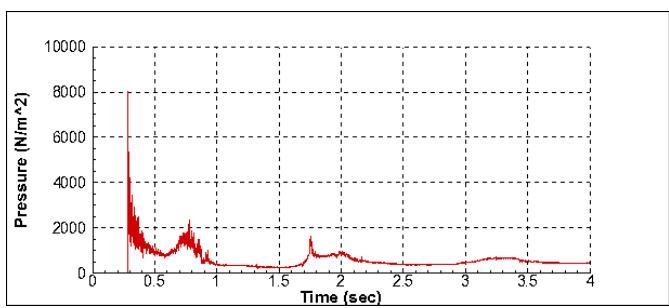
Figure 4. Time history of pressure at measuring point.